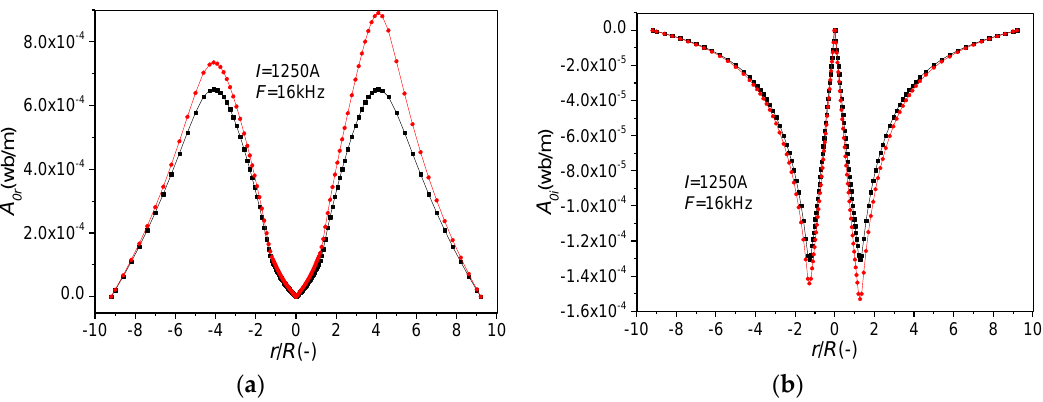
Figure 5. Contours of A 0 r for axisymmetric and spiral coils at I = 1250 A and F = 16 kHz. ( a ) axisymmetric coil; ( b ) spiral coil.